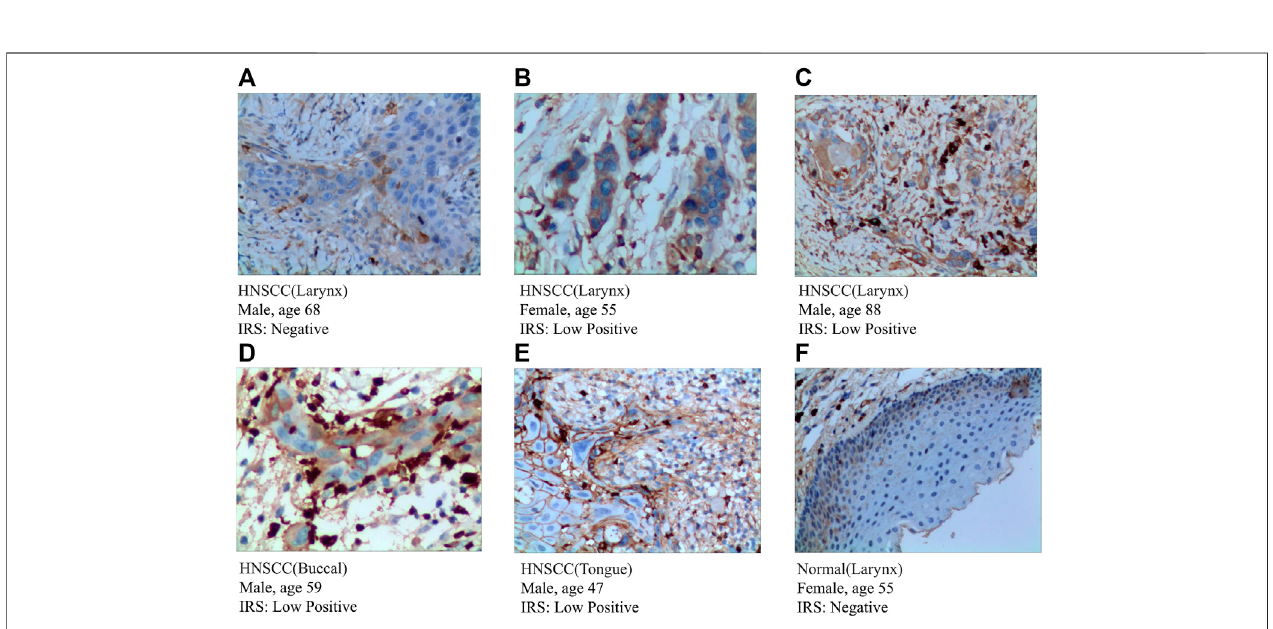
FIGURE 7 | IHC analysis of the protein expression of SEMA3C in HNSCC and normal tissues. (A – E) The expression of SEMA3C was detected by IHC in fi ve patients with HNSCC (Magni fi cation ×200). (F) The expression of SEMA3C was detected by IHC in normal head and neck squamous cell tissue (Magni fi cation ×200).